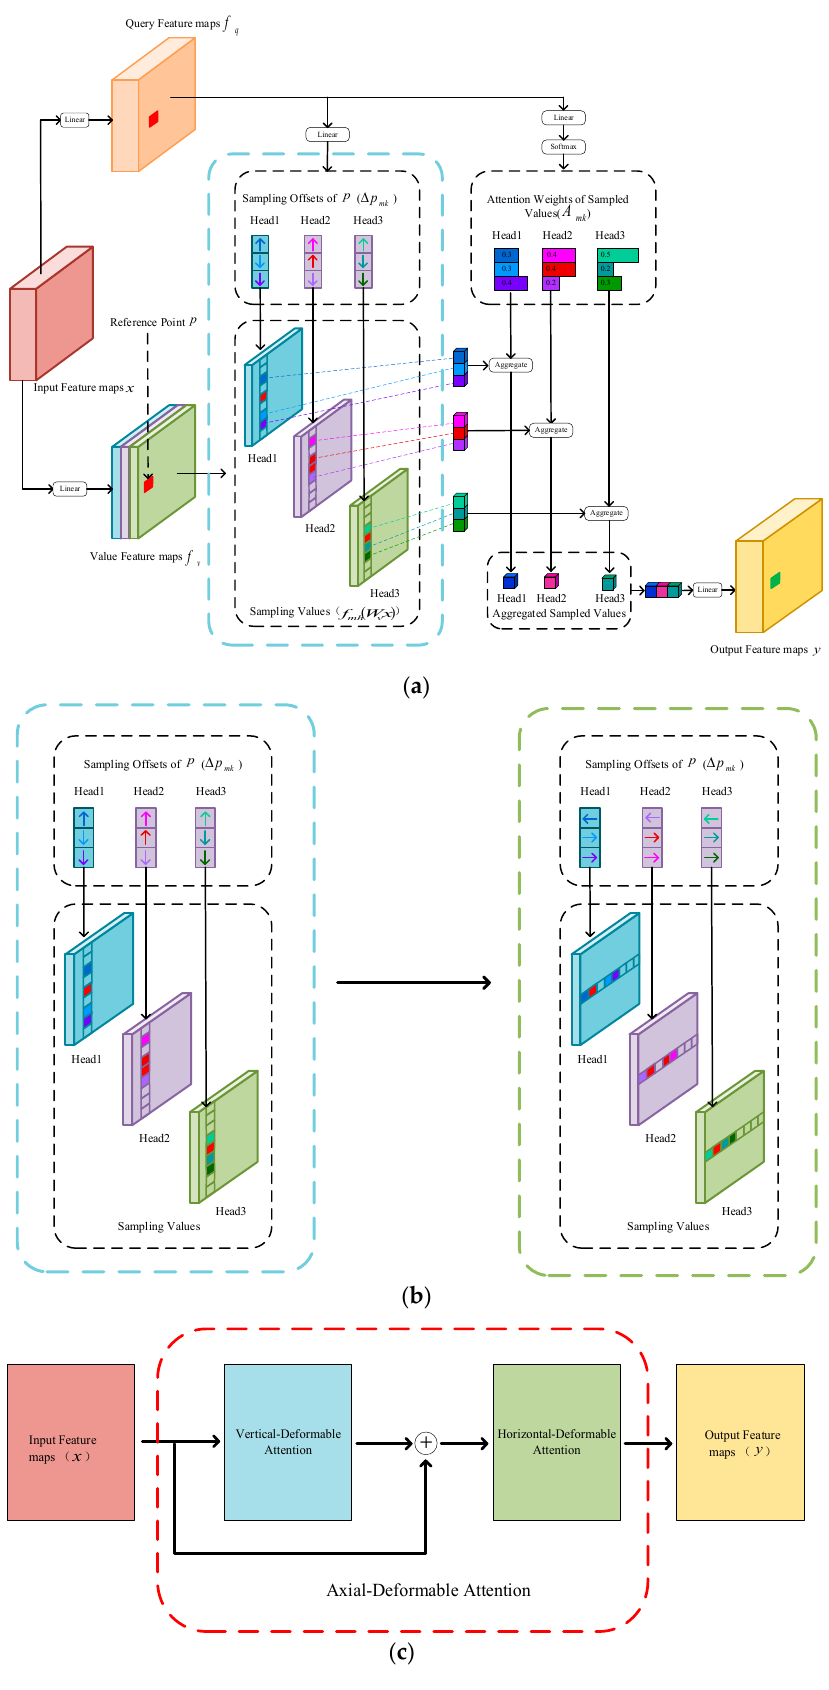
Figure 2. ( a ) Illustration of VDAM. ( b ) Illustration of converting VDAM into HDAM. ( c ) Schematic diagram of the proposed ADA module.